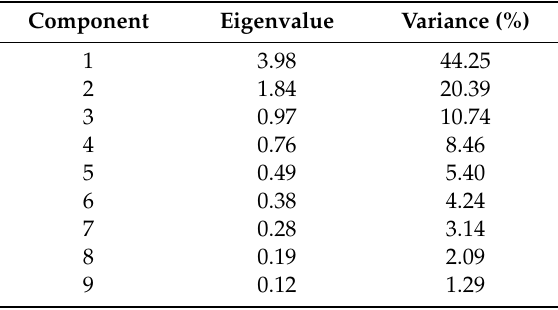
Table 4. Results of the extracted principal components. Only the first two have eigenvalues higher than 1. The sum of the variance explained by the first two components is about 65%.